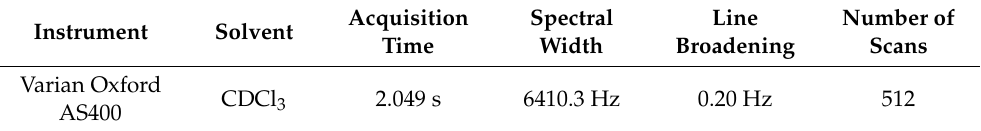
Table 5. 1 H-NMR acquisition